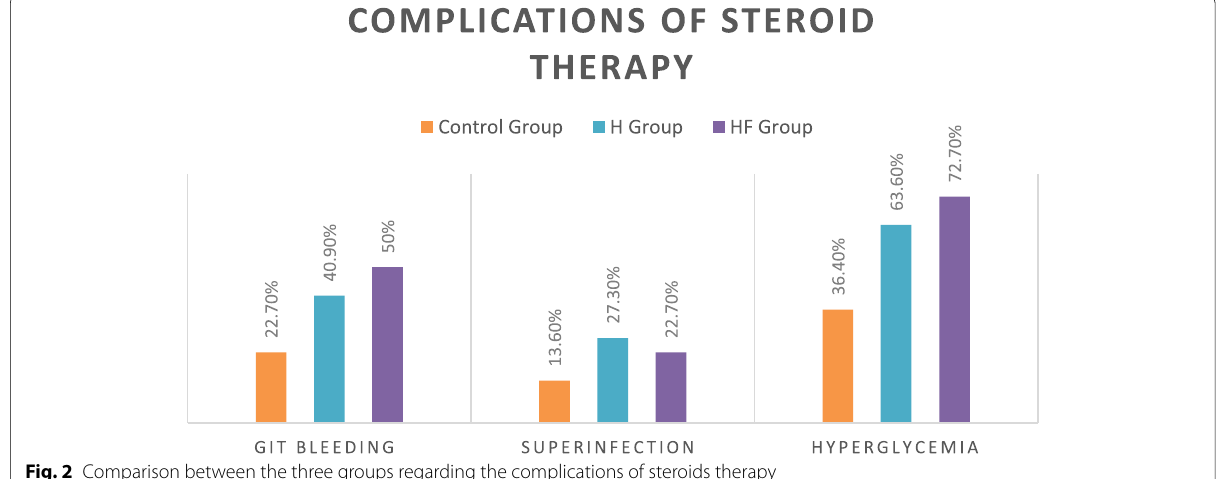
Fig. 2 Comparison between the three groups regarding the complications of steroids